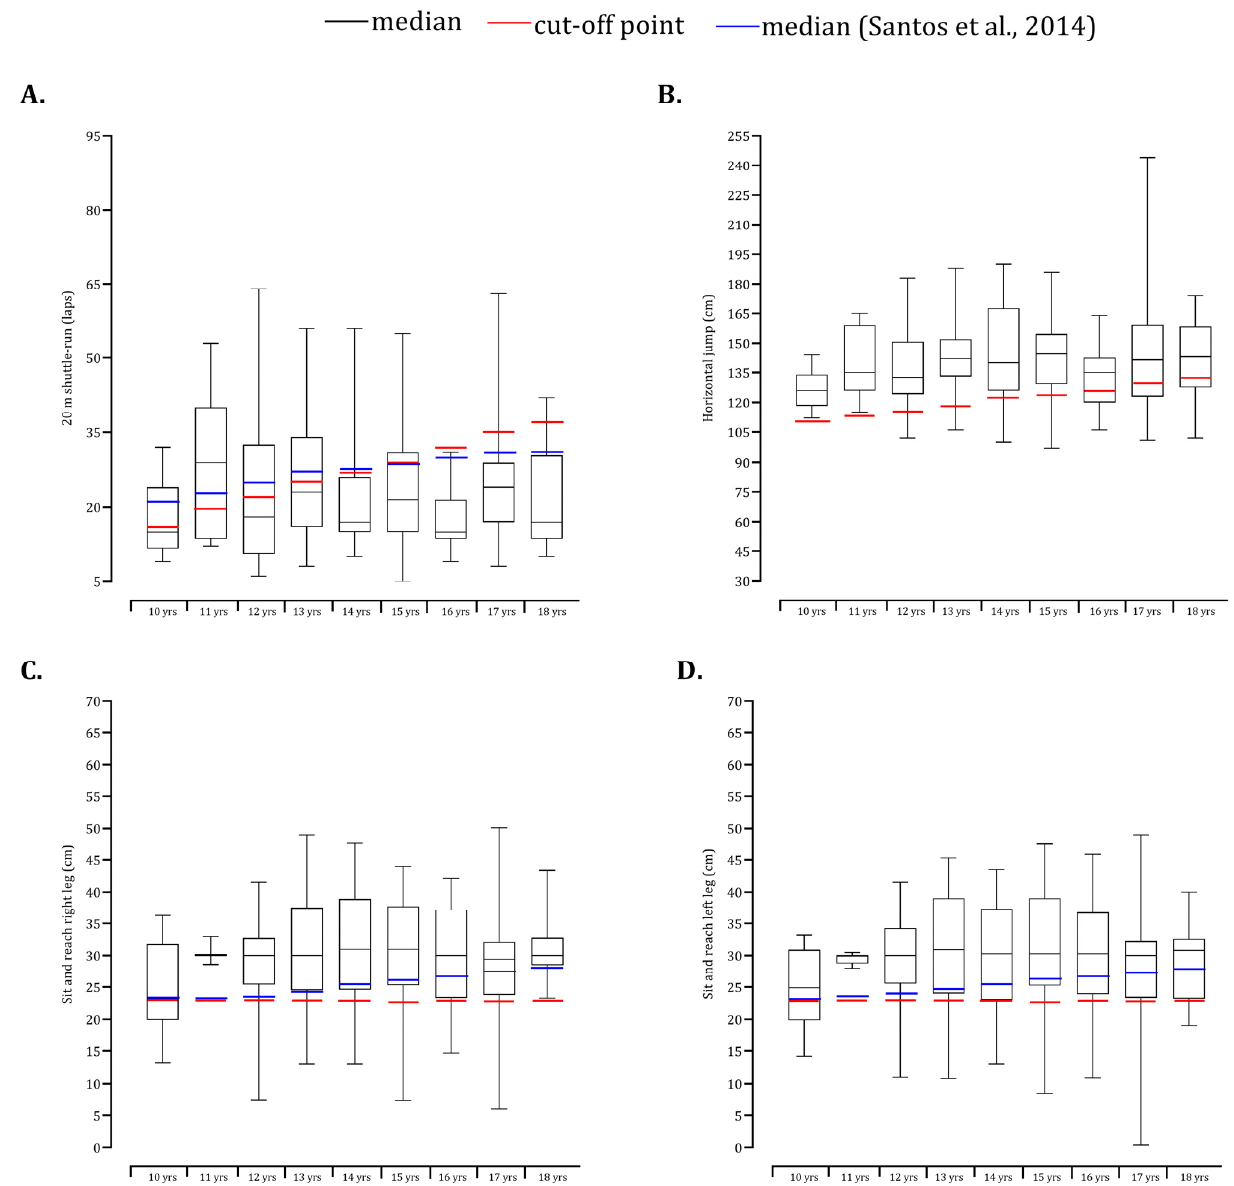
Figure 5. Box and whisker plots of school female participants plotted relative to cut-off standards for fitness battery (20 m shuttle-run: ( A ); horizontal jump: ( B ); sit and reach right leg: ( C ); sit and reach left leg: ( D )) [14].